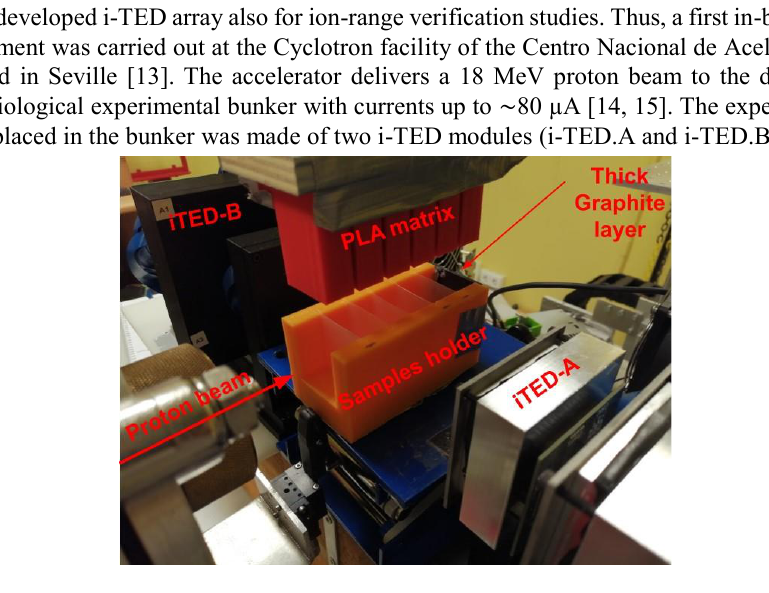
Figure. 1 . Picture of the experimental setup. The different parts such as detectors, samples holder and others are labelled for a comprehensive understanding of the experimental